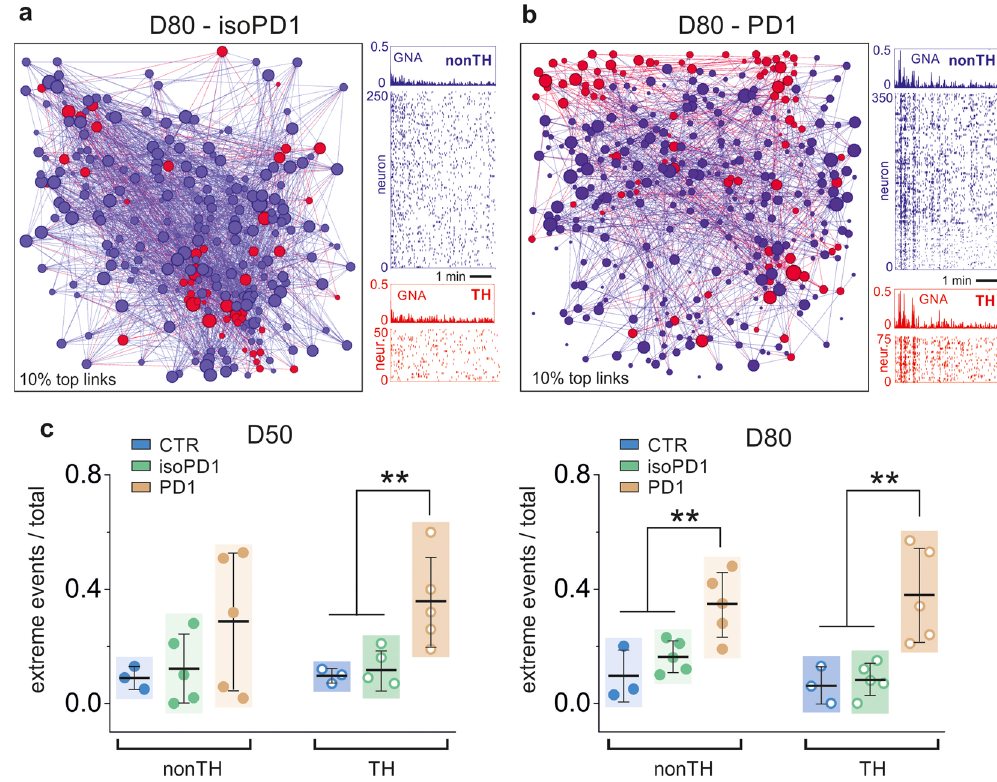
Fig. 4 Functional connectivity and dynamics of TH + and non-TH + neurons. a Left, representative functional network of an isoPD1 culture at D80, signaling the location of TH + neurons (red) and non-TH + neurons (blue). The diameter of a dot is proportional to the connectivity of the neuron it represents. Only 10% of the connections are shown for clarity. Right, corresponding raster plots of the two populations. b Corresponding analysis for a PD1 culture, in which the non-TH + subpopulation exhibits a much stronger synchronous behavior as compared to controls. c Ratio of extreme events for each subpopulation of neurons at two maturation stages, D50 and D80. PD cultures show in general a higher ratio of extreme events as compared to controls. The non-TH + population in the PD network at D50 shows a strong variability in the ratio of extreme events across realizations, indicating the onset of malfunction. The same population at D80 is dominated by extreme events that re fl ect the strong synchronous behavior. The colored boxes are a guide to visualize the distributions, which show the mean ± SD and the individual realizations (dots). The number of independent experiments in panel ( c ) are D50 (CTR: n = 3, isoPD1: 5, PD1: 5); D80 (3, 5, 5). *** p < 0.001; ** p < 0.01; * p < 0.05 (ANOVA with multiple comparison